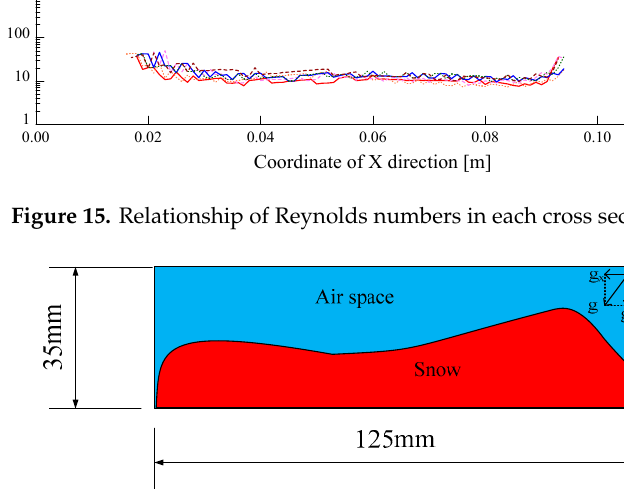
Figure 16. Numerical model used in the simulation. Table 3. Input parameters of snow.